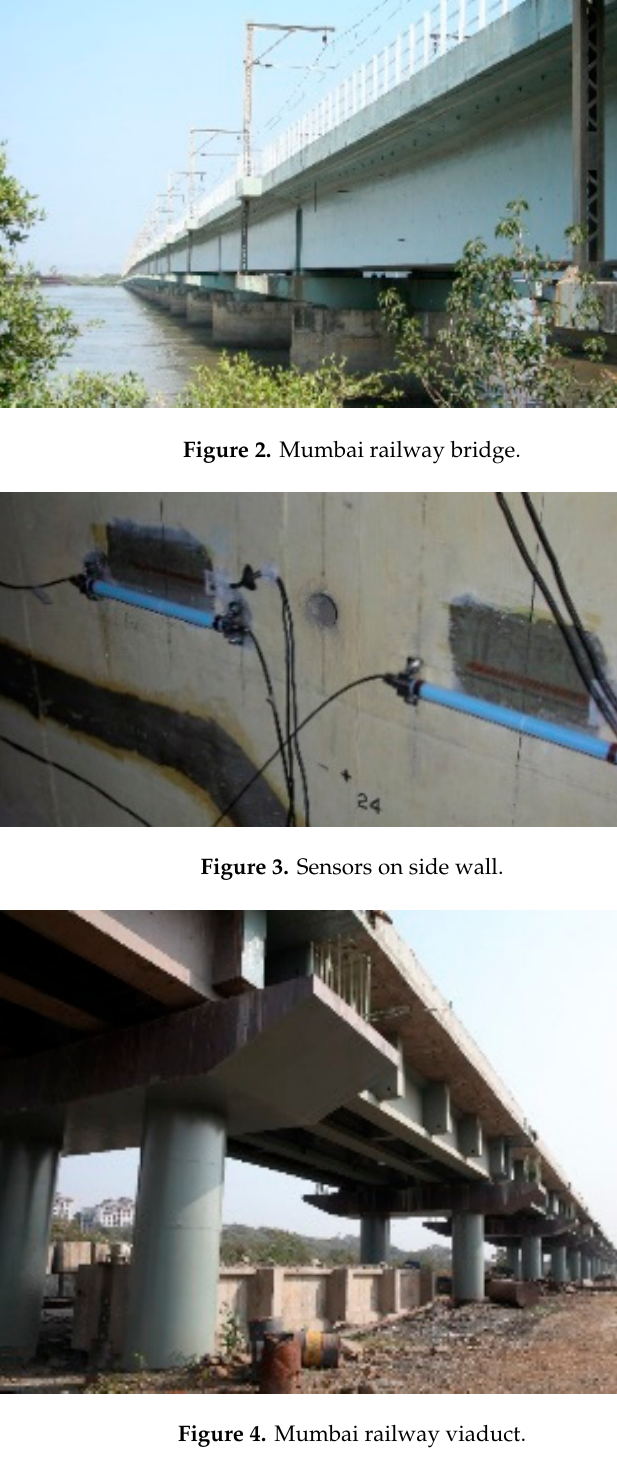
Figure 4. Mumbai railway viaduct.